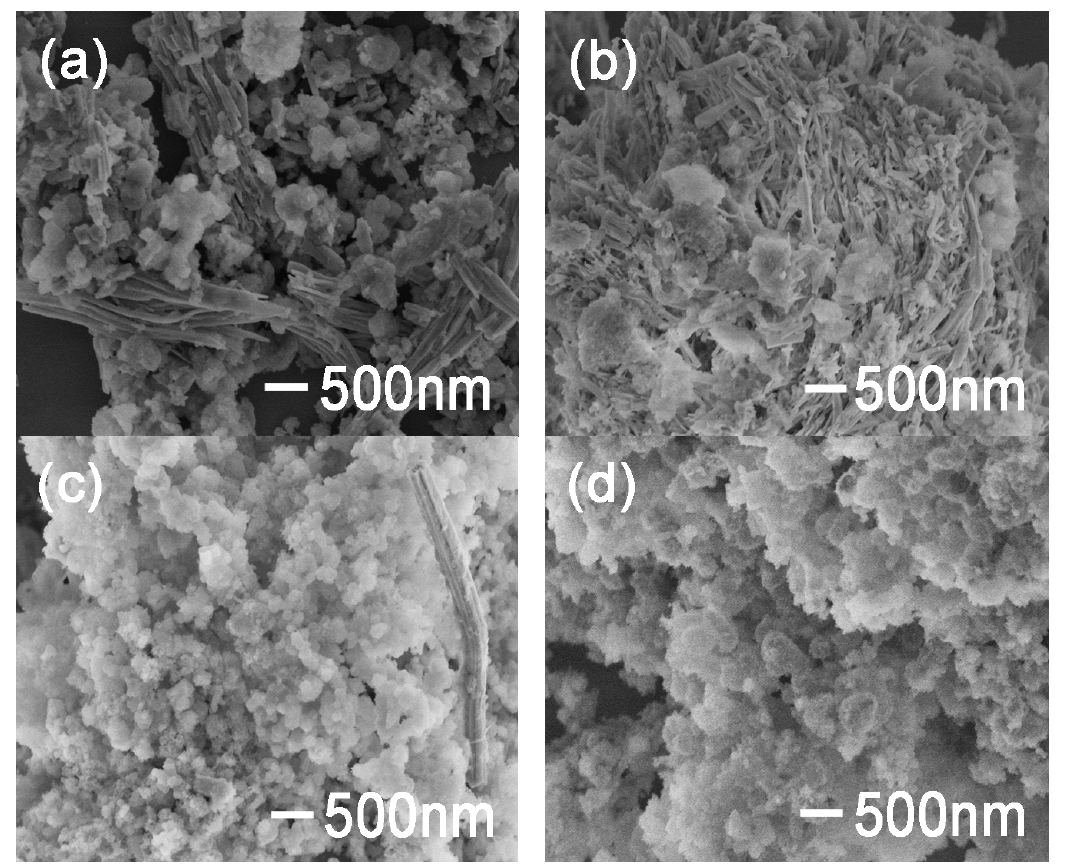
Figure 2. SEM images of Eu 3+ -doped silica nanowires with different dosages of H 2 O: ( a ) 2 mL; ( b ) 4 mL; ( c ) 8 mL; ( d ) 10 mL.